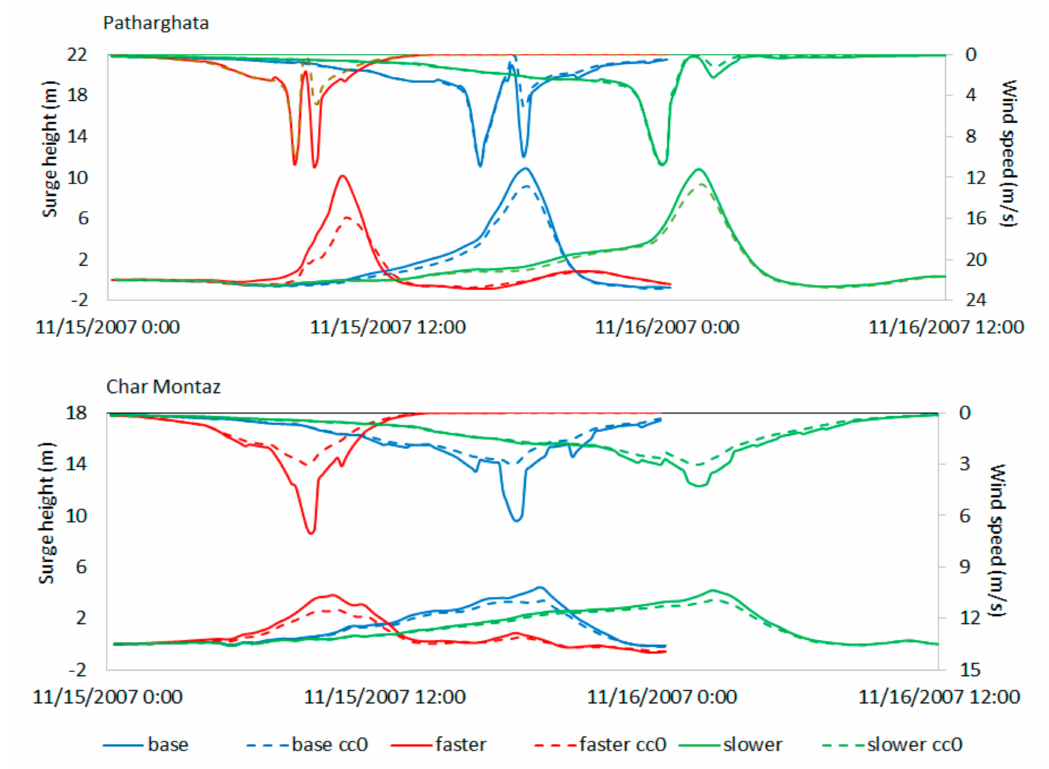
Figure 4. Computed wind speed and surge profiles during Cyclone Sidr; at Patharghata ( upper panel ) and at Char Montaz ( lower panel ). Surge profiles are plotted in primary axis and wind speed in secondary axis. Computations including translation speed are represented by firm lines and those excluding translation speed are represented by dotted